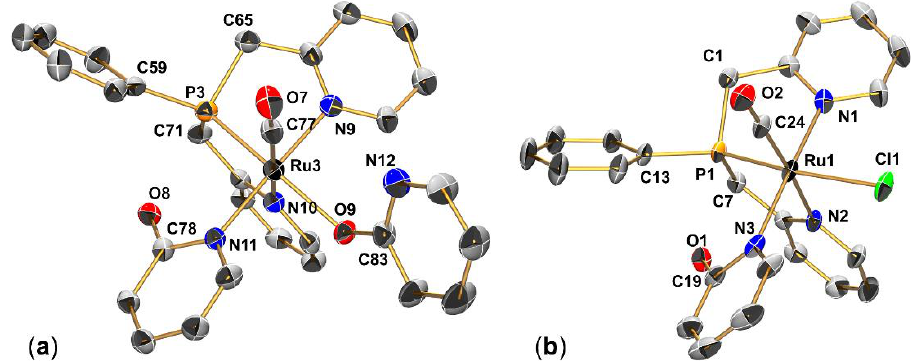
Figure 3. ( a ) Molecular structure of 4a in the crystal structure of 4a · (toluene) (thermal displacement ellipsoids drawn at the 30% probability level, selected atoms labeled, H-atoms and solvent molecules are omitted for clarity). The asymmetric unit contains four molecules of 4a in very similar conformation; thus, only one of them is shown as a representative example. Selected interatomic distances (Å) and angles (deg.) of 4a : Ru3–P3 2.2237(14), Ru3–O9 2.143(3), Ru3–N9 2.119(5), Ru3–N10